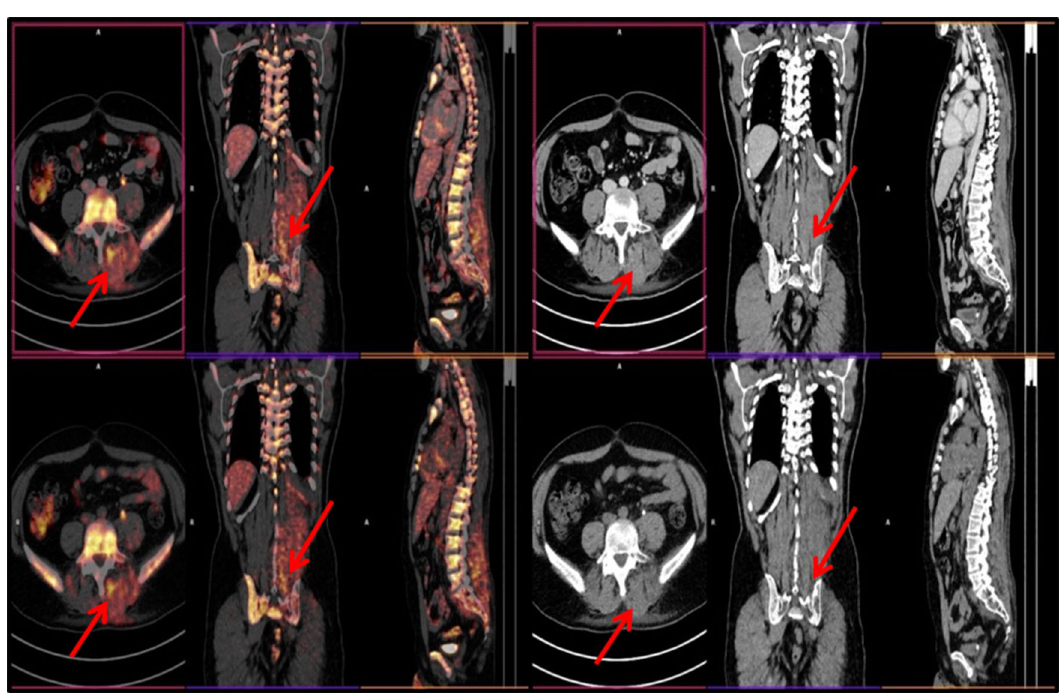
Figure 2. PET/ldCT and PET/ceCT showed paravertebral tissue infiltration [DS 5; SUVmax